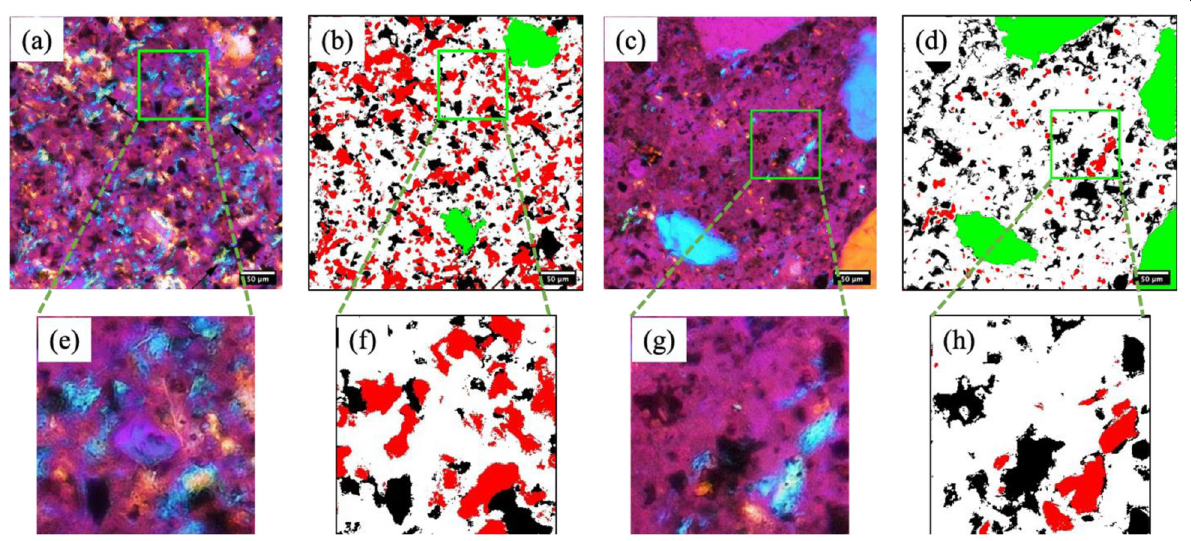
Fig. 9 a & c Transmitted light photomicrographs showing paste in the middle of a undamaged field mortar and c damaged field mortar, respectively, in cross-polarized light with the gypsum first order retardation plate inserted. b & d Segmentation images of the photomicrographs in ( a and c ) using 2D Trainable Weka Segmentation in ImageJ [36]. e - h Zoomed-in images of the corresponding zones in ( a - d ). The size of the zone in ( e - h ) is 100 μ m by 100 μ